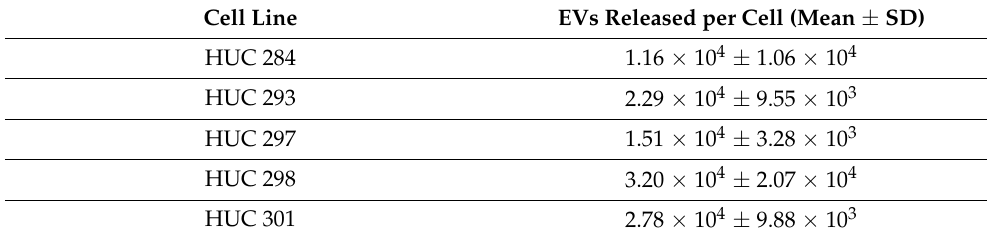
Table 2. EVs released per cell by line.